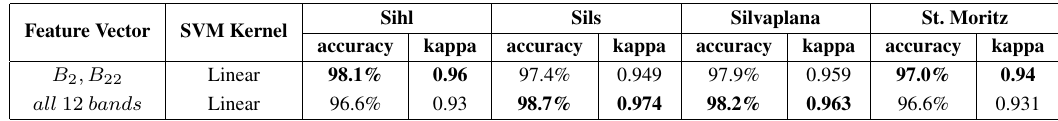
Table 11: Generalization across lakes: MODIS results when the SVM is trained on three lakes and tested on the fourth combining data from both winter 2011 - 12 and winter 2016 - 17